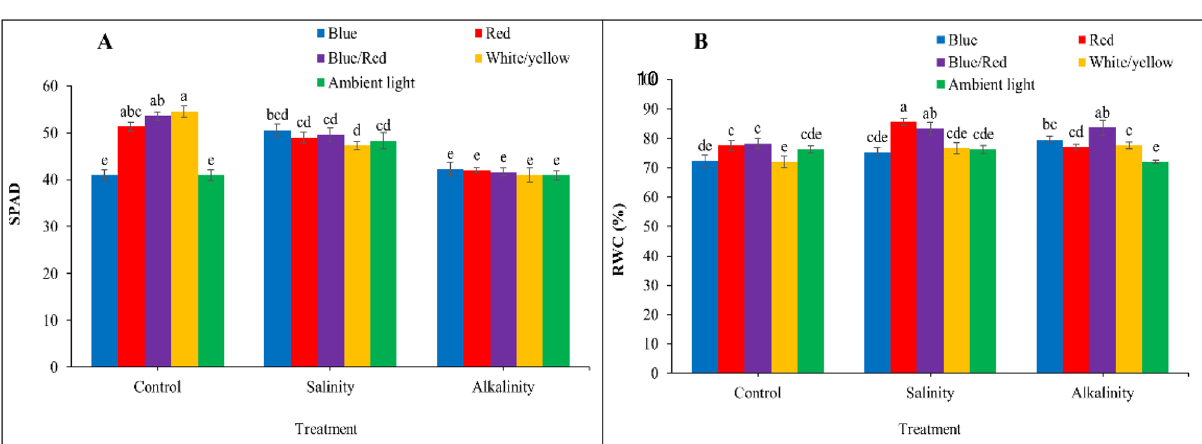
Figure 3. Changes in SPAD ( A ) and RWC ( B ) index under the effect of five light spectrum levels and three stress levels in three repetitions in strawberries cv. Camarosa. Means followed by the same letter for a parameter, are not significantly different according to the Duncan (P ≤ 0.05). Vertical bars indicate the standard errors of three replicates. SAS software version 9.4 was used for data analysis. The graphs were drawn using Microsoft Excel Reproductive characteristics and fruit soluble solids. The highest number of inflorescences and fruits was obtained in blue/red light treatment and control. Under salinity and alkali stress conditions, blue/red light caused a significant increase in inflorescences and fruits compared to other light spectra. Under salinity and alkalinity stress conditions, the highest early yield was observed in red and white/yellow light, respectively. Under salinity stress, blue/red light, and alkaline stress, white/yellow light caused the greatest increase in fruit length and diameter. The highest soluble solids content in fruit was observed under blue/red light and the lowest under non-supplemented light treatment (ambient light). According to our results, blue/red light had the great- est effect on inflorescence and fruit set, and white/yellow light had the greatest effect on fruit size and yield. Stress conditions reduced inflorescence, fruit number, and fruit size (Table 4).